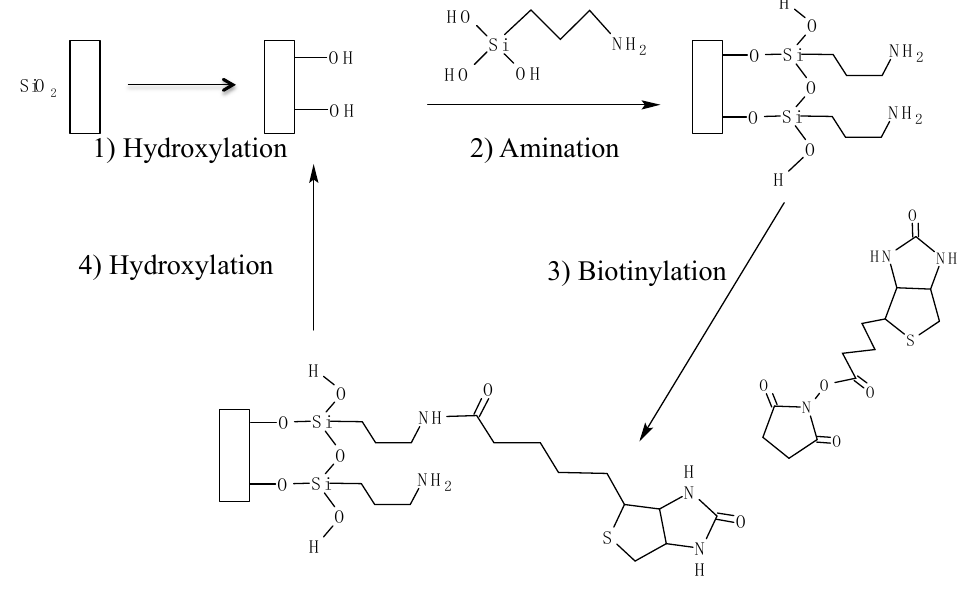
Figure 5. Overall reaction scheme for the biotinylation of silica surfaces (based on reference [36]). (1) Hydroxylation of the silica surface; (2) Amination of the hydroxylated surface via the silane coupling agent; (3) Biotinylation of the aminated surface via NHS